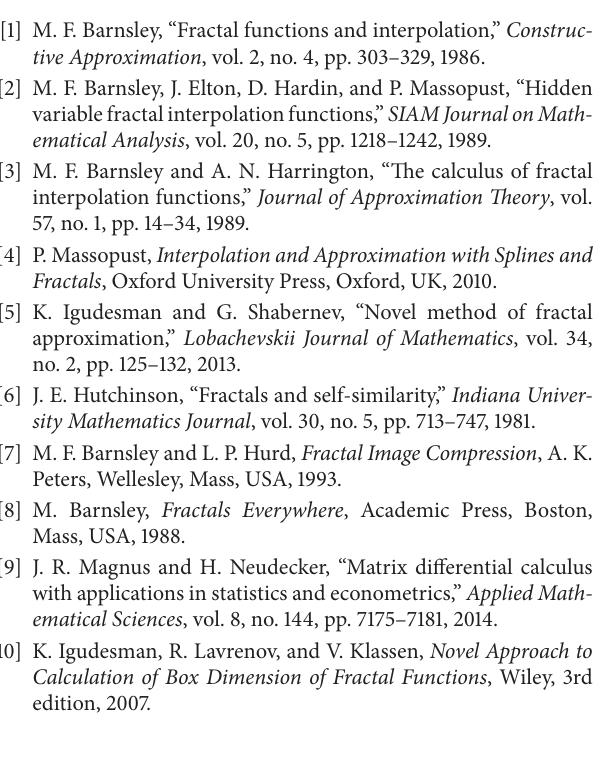
Figure 7: Weierstrass function (blue one) and approximating vector-function (red